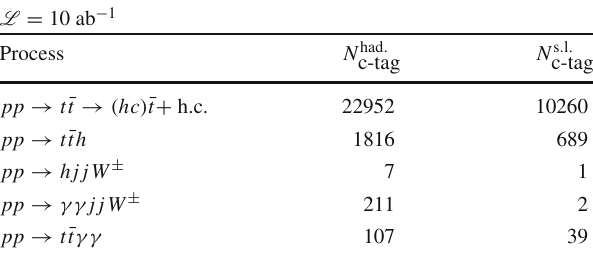
Table 4 The expected signal and background events at an integrated luminosity of L = 10 ab − 1 after applying the analyses in the search for the t → hc decay. The resulting event yields are shown for the case where charm-jet tagging is considered for the hadronic and semi- leptonic cases, see main text for further details. As before, the signal cross sections are shown for the working value λ h ct = 0 .